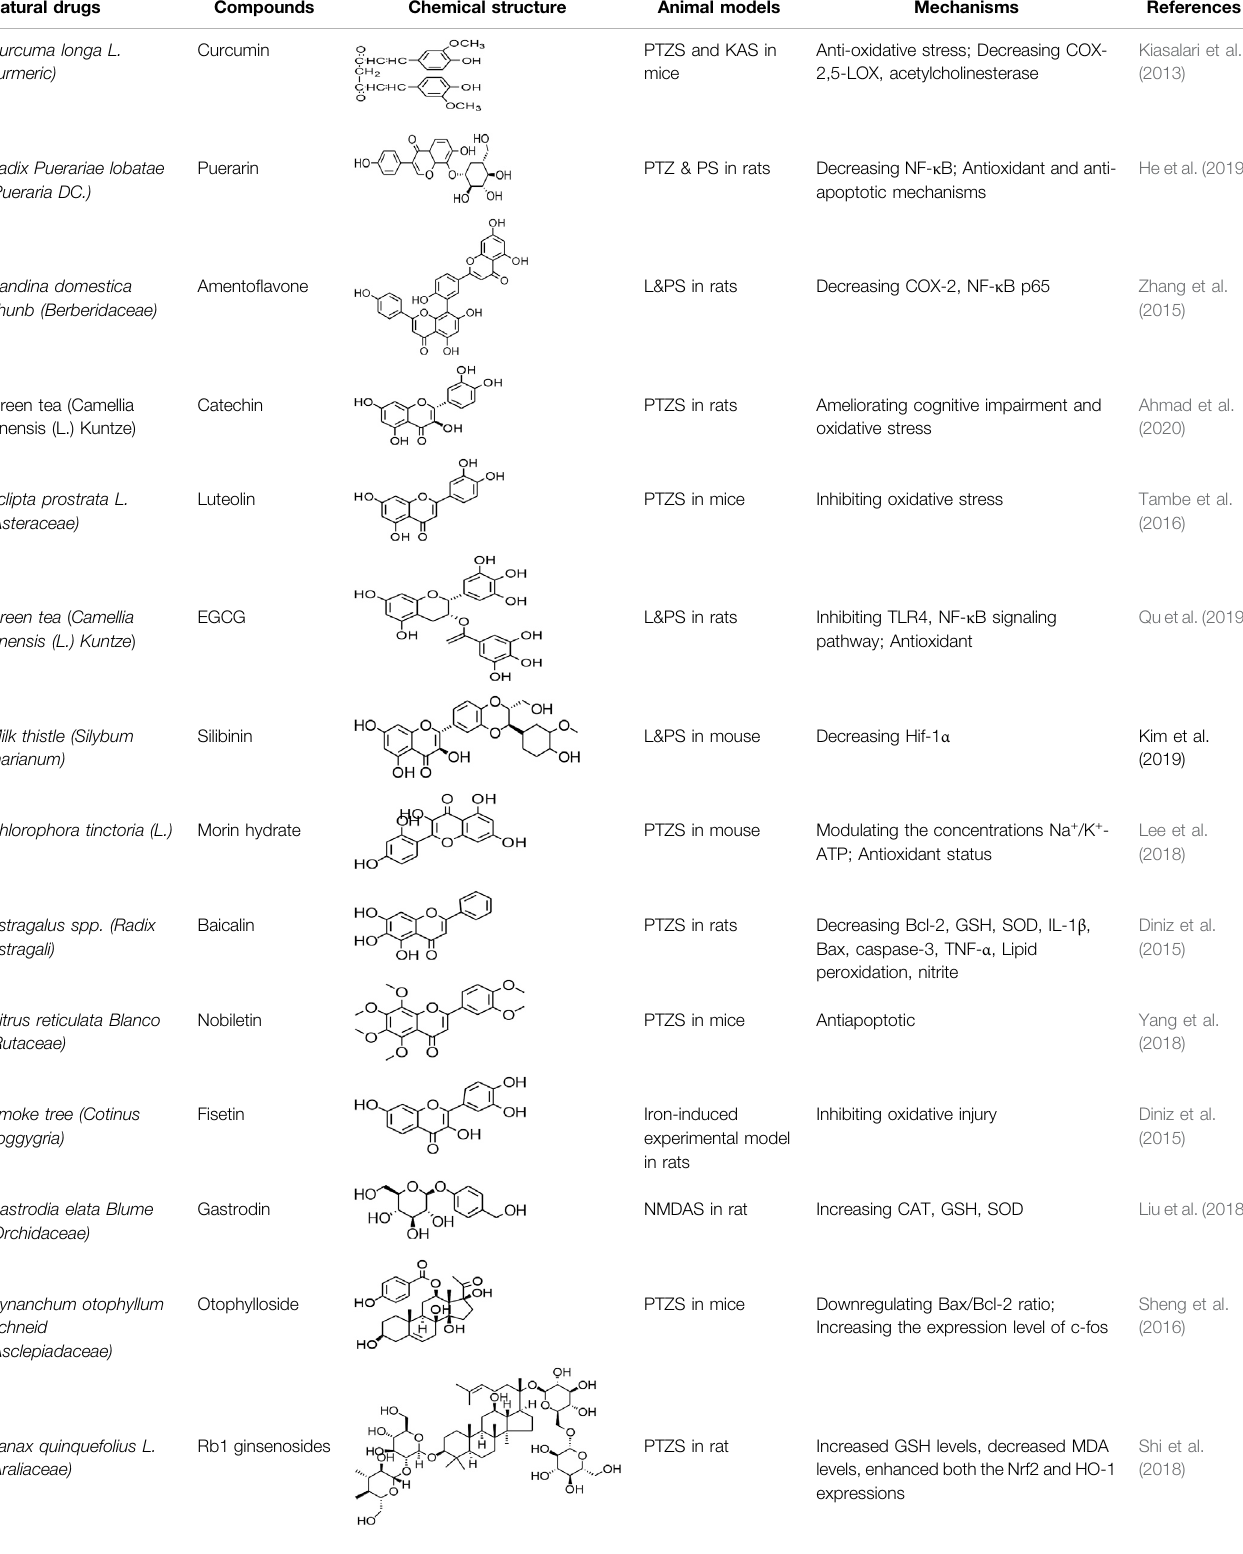
TABLE 6 | Natural drugs used to treat epilepsy by regulating mitochondrial damage and oxidative